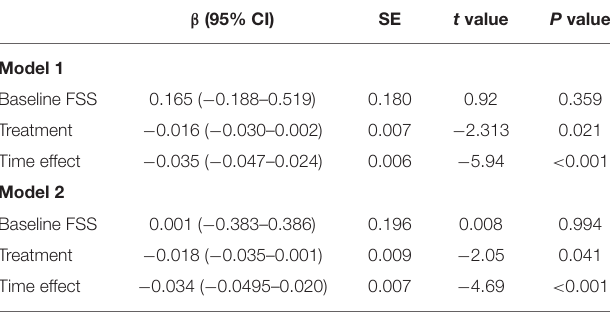
TABLE 4 | Multiple linear mixed-effect regression analysis of the relationship between SSRIs and PSF in the PSD subgroup during the 24-month follow-up